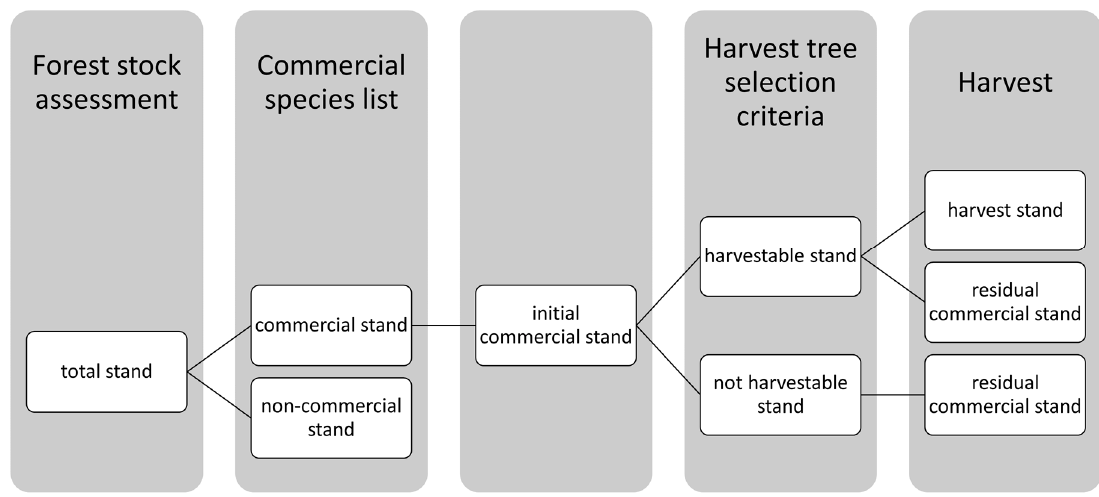
Figure 2. Systematics of stand terminology.